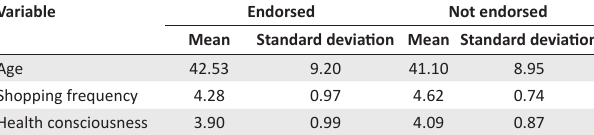
TABLE 3: Descriptive statistics for endorsed group and not endorsed group. Variable Endorsed